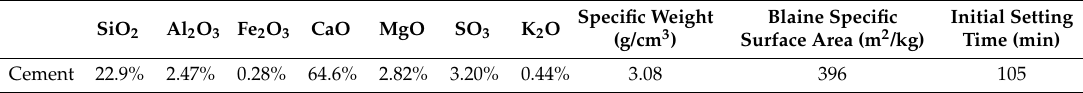
Table 1. Chemical composition wt % and physical properties of